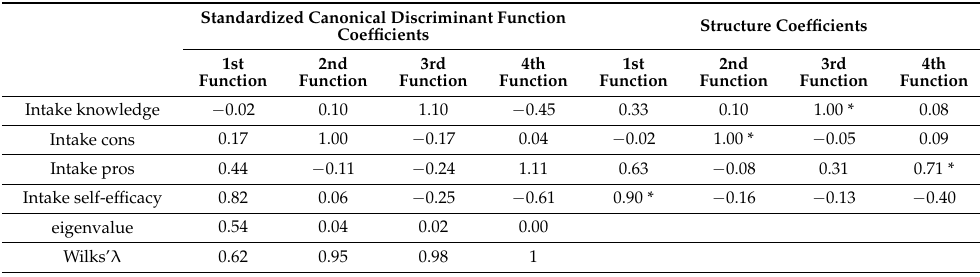
Table 4. Discriminant analysis of variables on stages of change (n = 342).